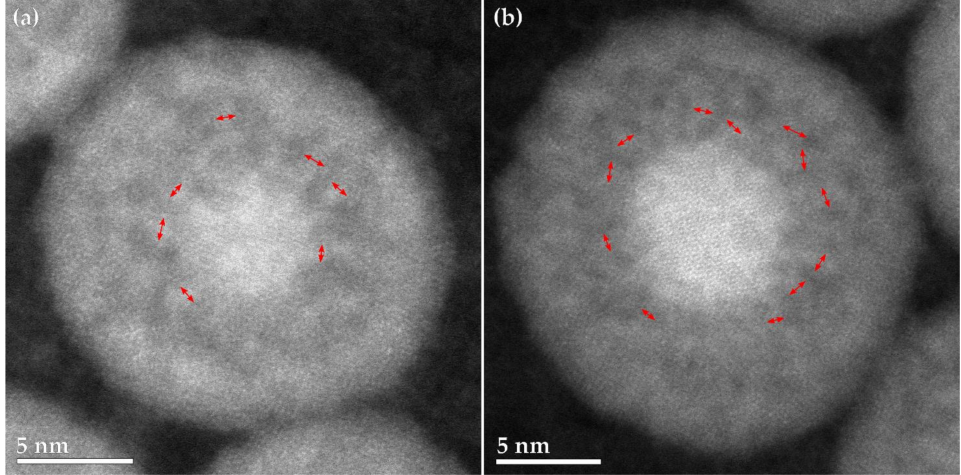
Figure 5. ( a , b ) High-resolution HAADF-STEM image of partially oxidized nanoparticles of Fe 2 C. Red double-sided arrows indicate the bridge material crossing the